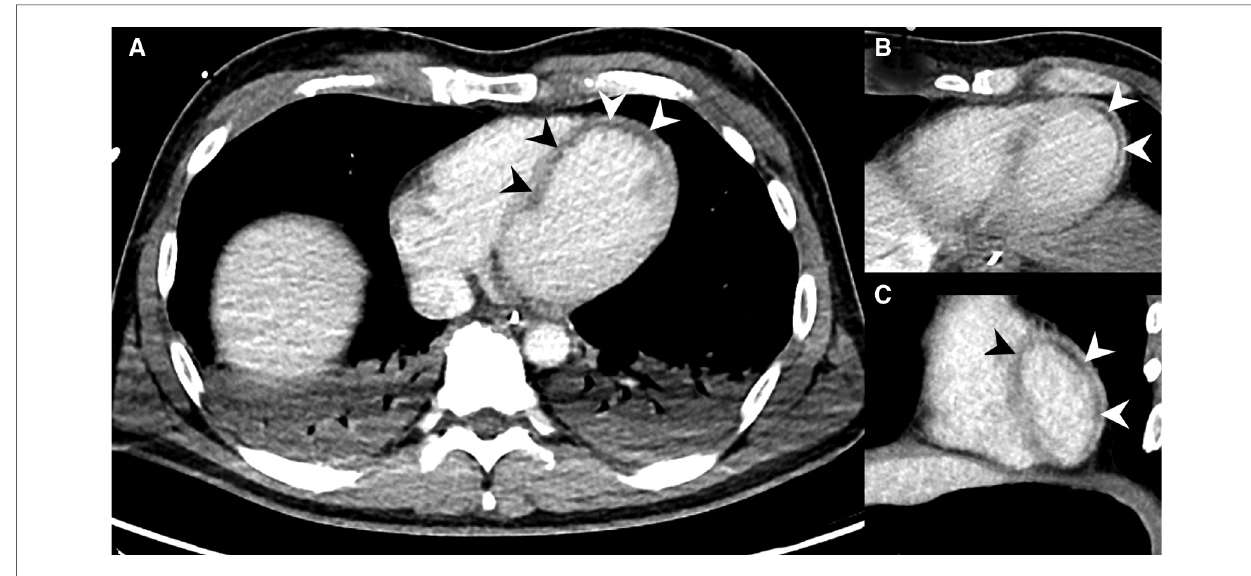
FIGURE 6 MDCT examination of a 43-year-old male, who was required to be resuscitated in the emergency room with suspected pulmonary embolism. The patient was referred for MDCT with a delay of three hours. The abdominal MDCT series showed MH (arrowheads) in the vascular territory of the left anterior descending artery (LAD) in axial slices ( A , B ) and coronal reformations ( C ), which was immediately communicated to the treating physicians. Stents were placed in both coronary arteries during emergency PTCA. The patient died two days later as a result of his